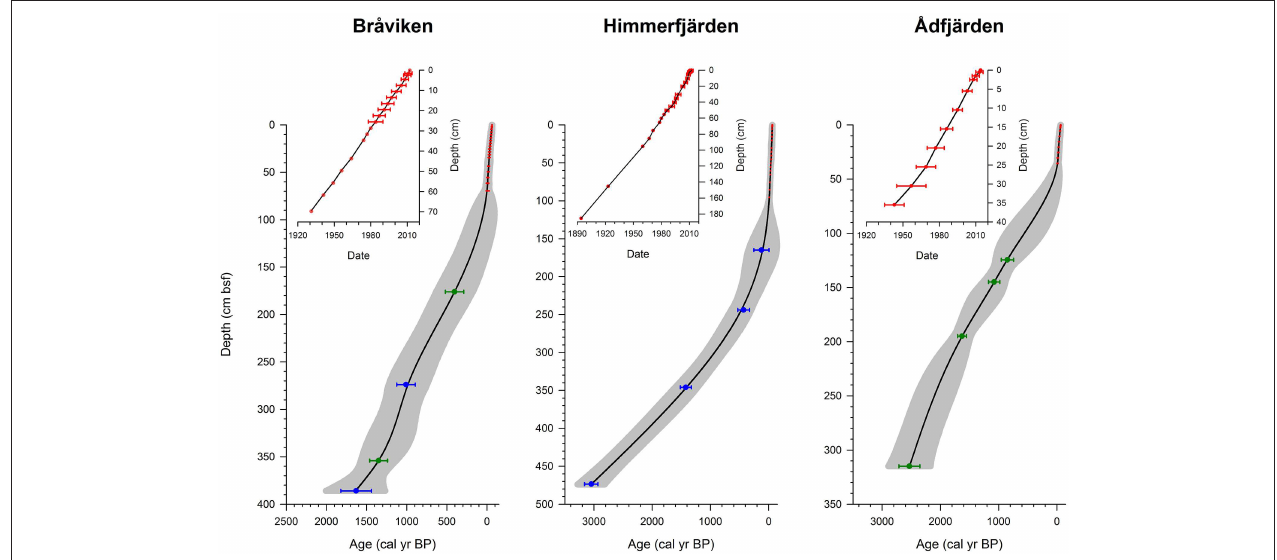
FIGURE 3 | Age-depth plots based on 210 Pb (upper panel) and 14 C (lower panel). The age-depth 14 C curves are spline smoothed and the gray shaded area indicates the uncertainty (1 sigma) in the modeling. Samples marked in green are terrestrial macrofossils calibrated with IntCal13 and samples marked in blue are marine macrofossils calibrated with Marine13.